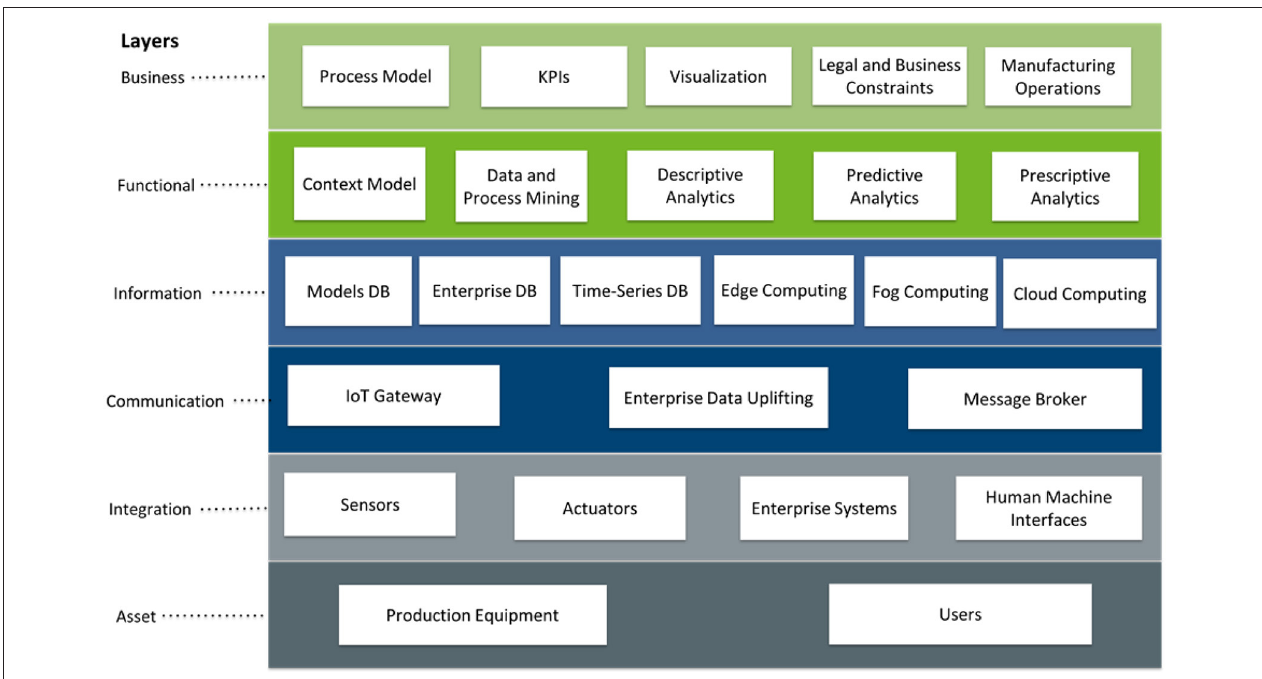
FIGURE 2 | Big data technologies and functions for manufacturing operations in the frame of RAMI 4.0 Architecture